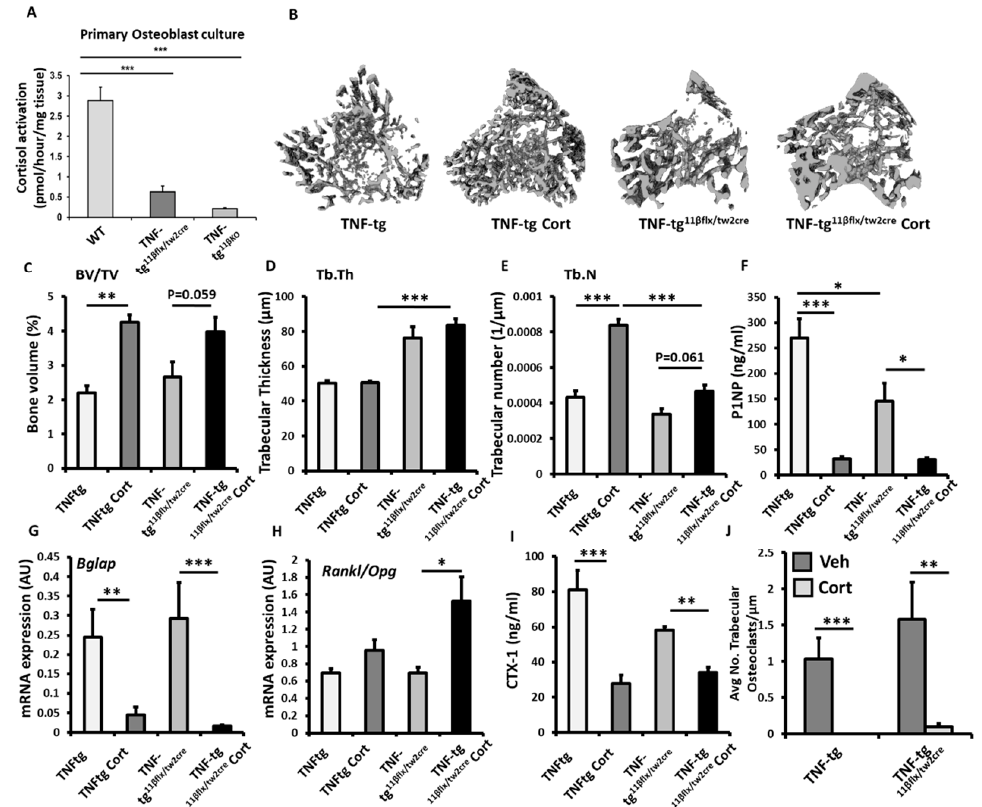
Figure 4. ( A ) Glucocorticoid activation by 11 β -HSD1 over 24 h in primary murine calvaria osteoblast cultures isolated from wild type (WT), TNF-tg and TNF-tg 11 β flx/tw2cre animals determined by scanning thin layer chromatography. ( B ) Representative images of 3D reconstructions of tibia trabecular bone using micro-CT, ( C ) bone volume to tissue volume (BV/TV), ( D ) trabecular thickness (Tb.Th) and ( E ) trabecular number (Tb.N) determined by Meshlab software analysis of micro CT in TNF-tg and TNF-tg 11 β flx/tw2cre animals receiving either vehicle (Veh) or corticosterone (Cort) (100 µ g/mL) in drinking water over 3 weeks. ( F ) Serum P1NP (ng/mL), mRNA expression (AU) of ( G ) Bglap mRNA expression (AU), ( H ) RankL/Opg mRNA ratio in trabecular bone and ( I ) serum CTX-1 (ng/mL) in TNF-tg and TNF-tg 11 β flx/tw2cre animals receiving either vehicle or corticosterone (100 µ g/mL) in drinking water over 3 weeks determined by RT-qPCR or ELISA. ( J ) Average number of osteoclasts normalised to trabecular bone perimeter (N.Oc/Pm (mm)) in TNF-tg and TNF-tg 11 β flx/tw2cre animals receiving either vehicle or corticosterone (100 µ g/mL) in drinking water over 3 weeks determined using Image J analysis software following TRAP staining. Values are expressed as mean ± standard error of six animals, or 3 primary cell cultures per group. Statistical significance was determined using two-way ANOVA with a Tukey post hoc analysis. * p < 0.05, ** p < 0.005 and *** p <